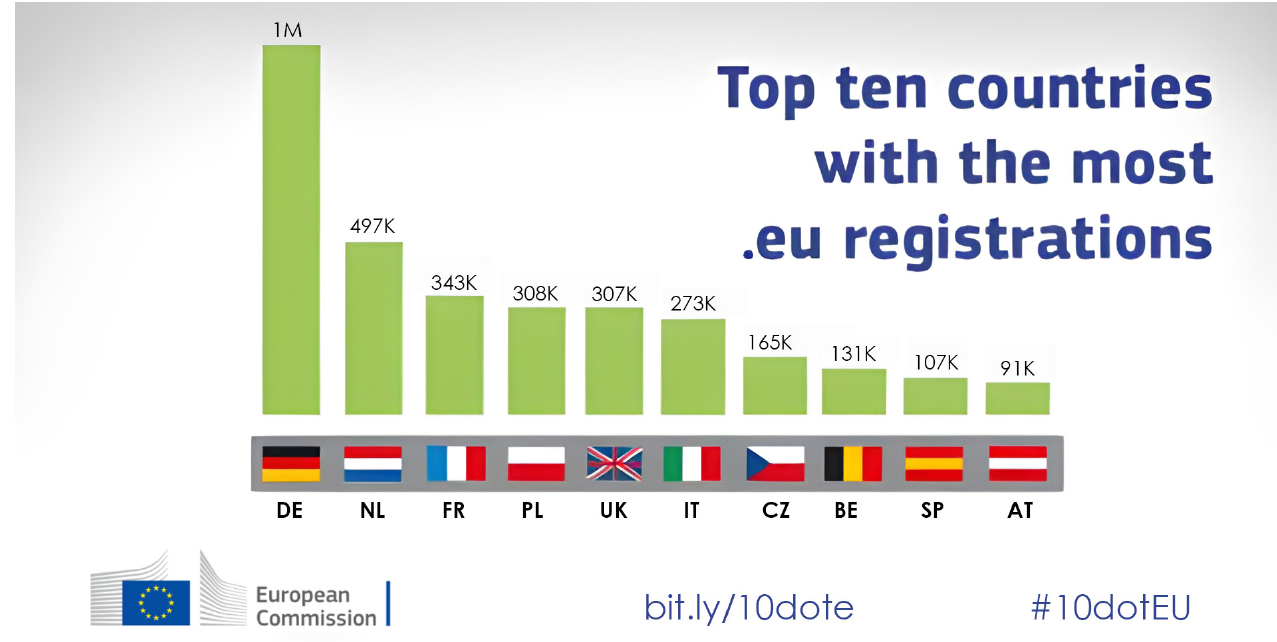
Figure 1. Top ten countries with the most .eu registrations in 2015 [11].